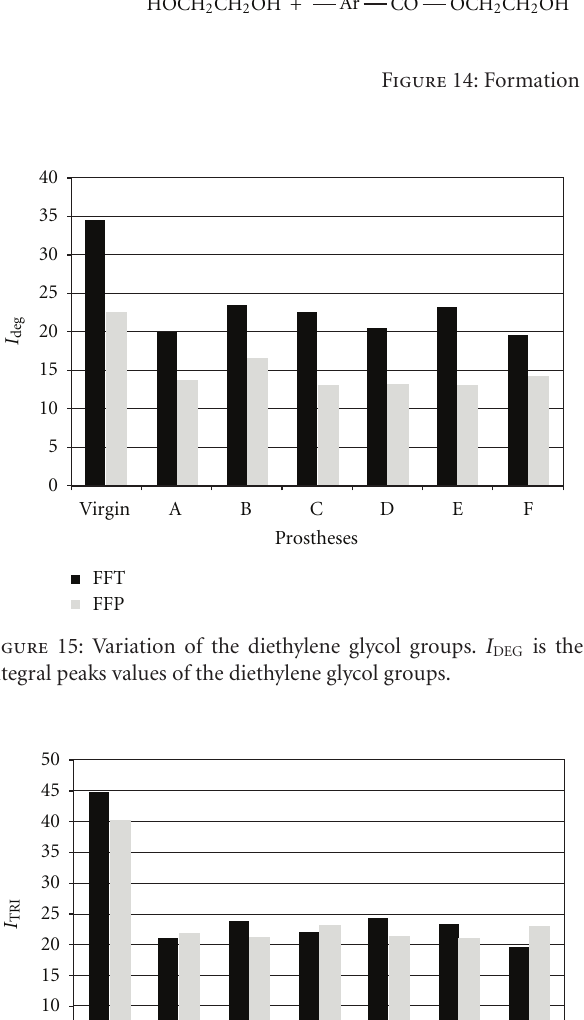
Figure 14: Formation of diethylene glycol (DEG).